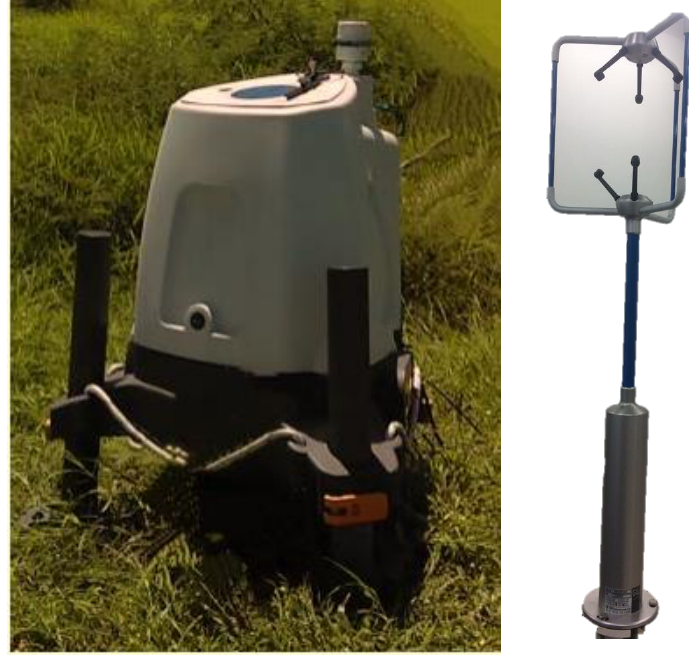
Figure 3. ZephIR LIDAR 300 (left) and 3D Gill WindMaster ultrasonic anemometer